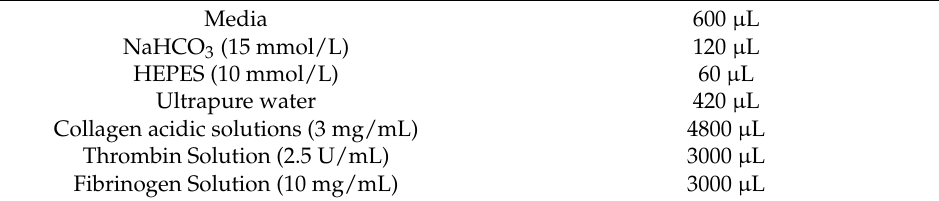
Figure A1. Procedure showing the preparation of the collagen scaffold. Table A1. The content of the collagen solution introduced in the step shown in Figure A1C. Table A2. The content of the collagen solution introduced in the step shown in Figure A1E.